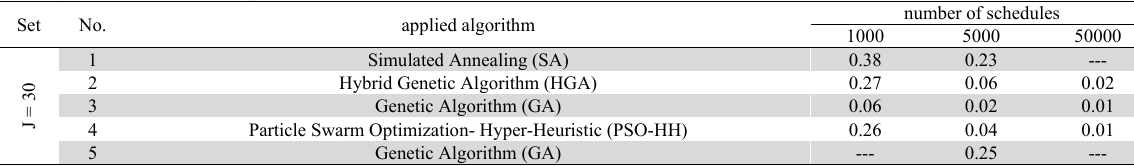
Average deviations from optimal solutions